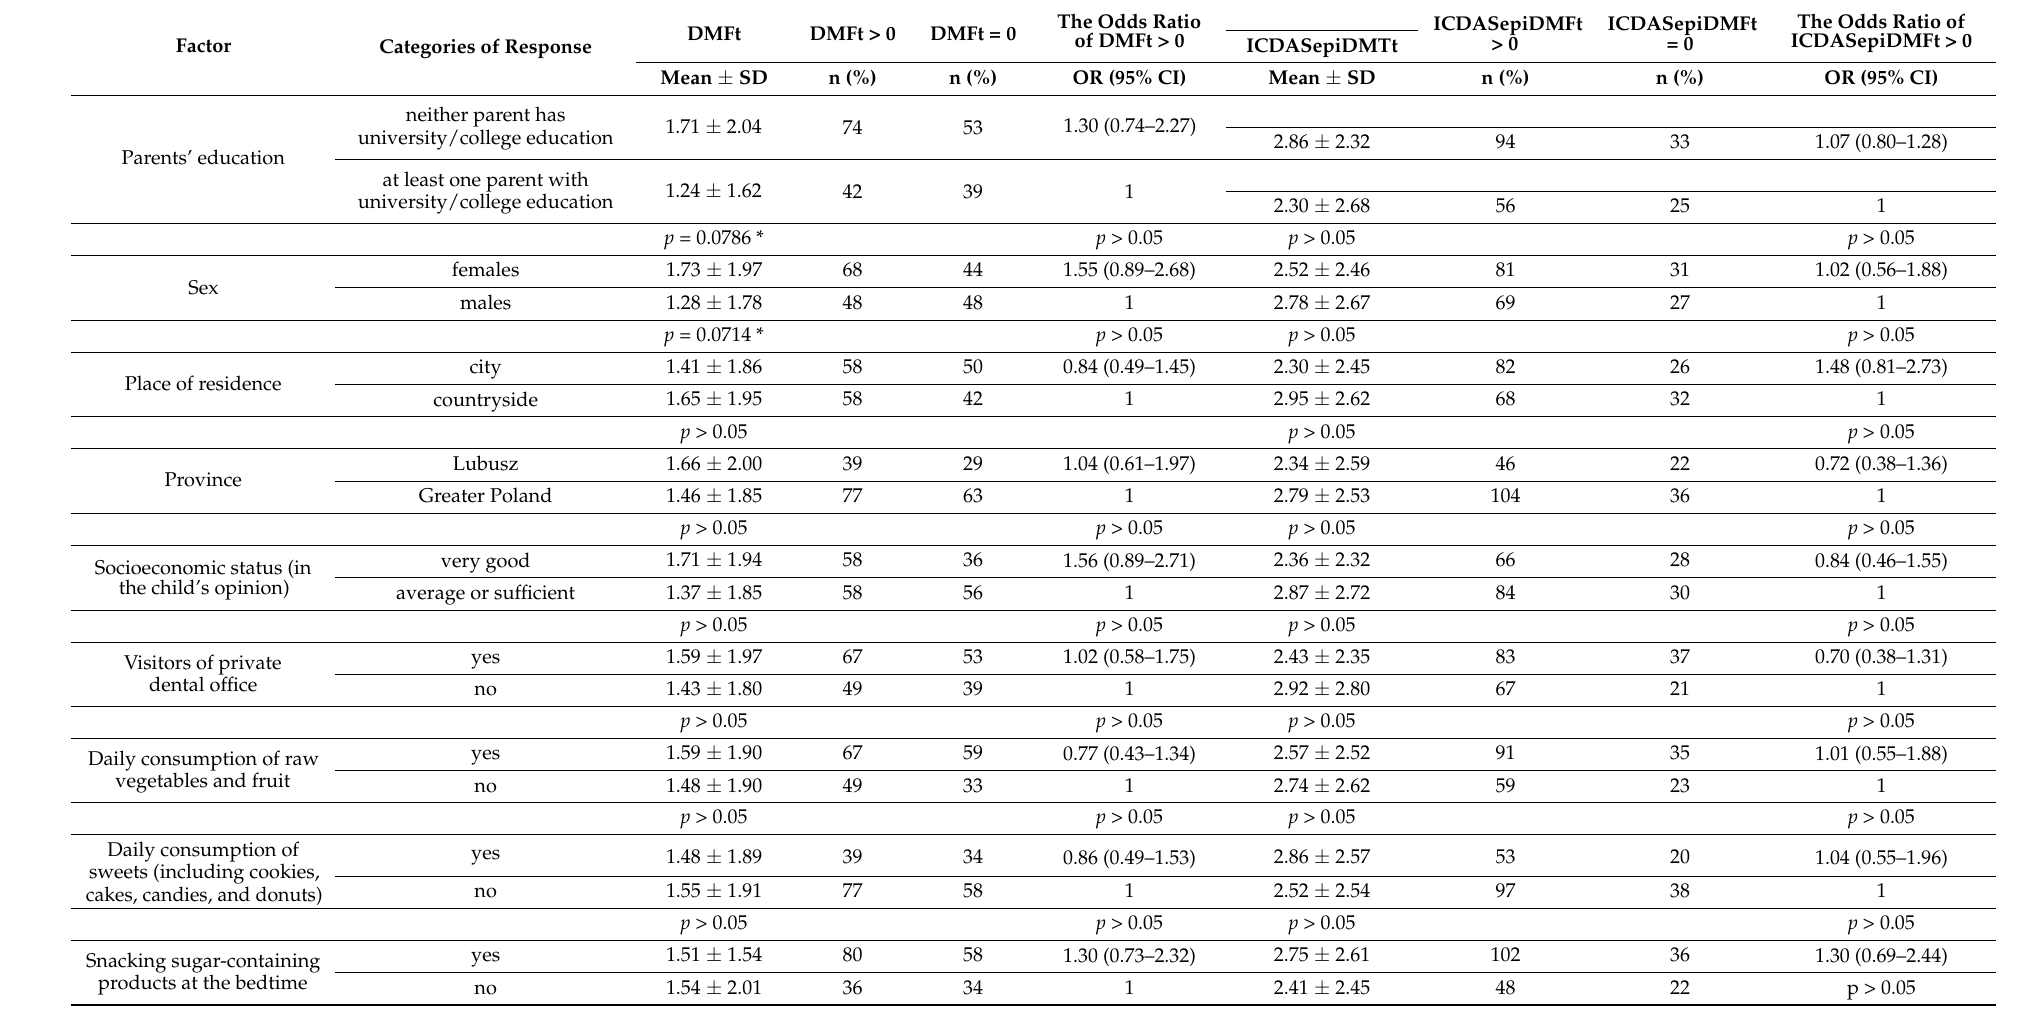
Table 5. An analysis of the factors associated with the development of dental caries in the examined